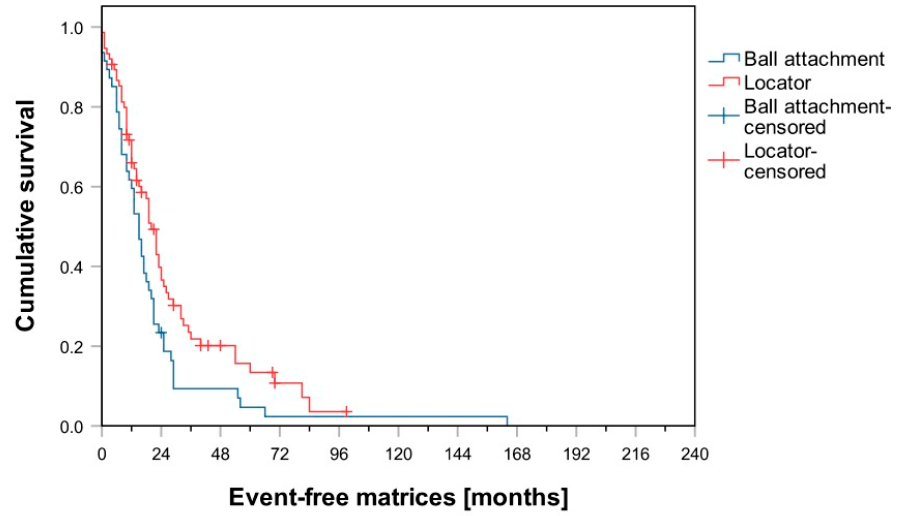
Figure 2. Kaplan–Meier survival curves for ball and Locator attachments regarding matrix-related events.